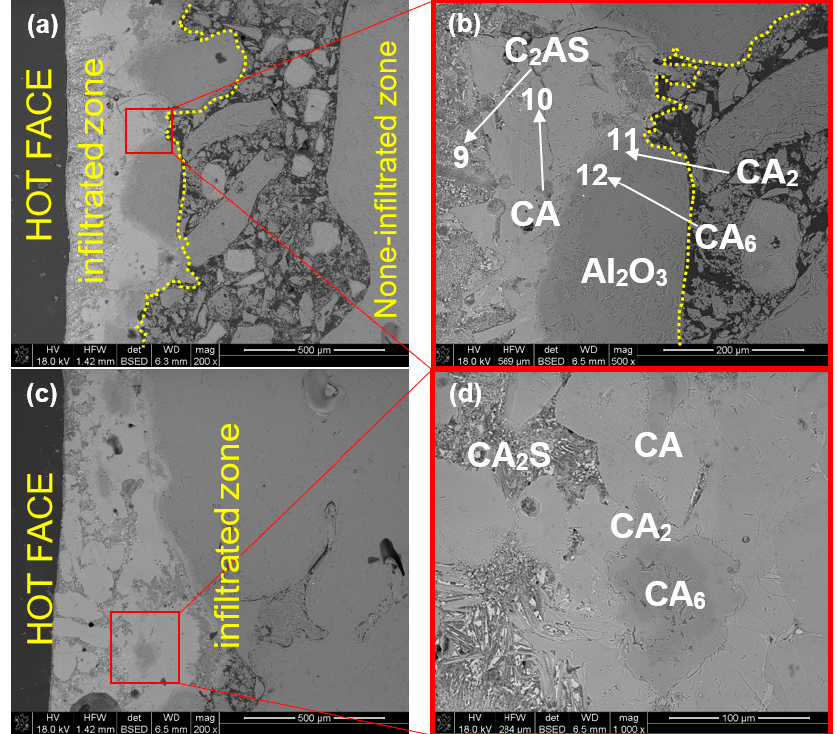
Figure 14. SEM images of sample Al-2-1 corroded by slag S (1350 °C, 10 h); ( a , c ) hot-face zone of the impregnated area, ( b , d ) high magnification of ho-face zone (slag/refractory interface).